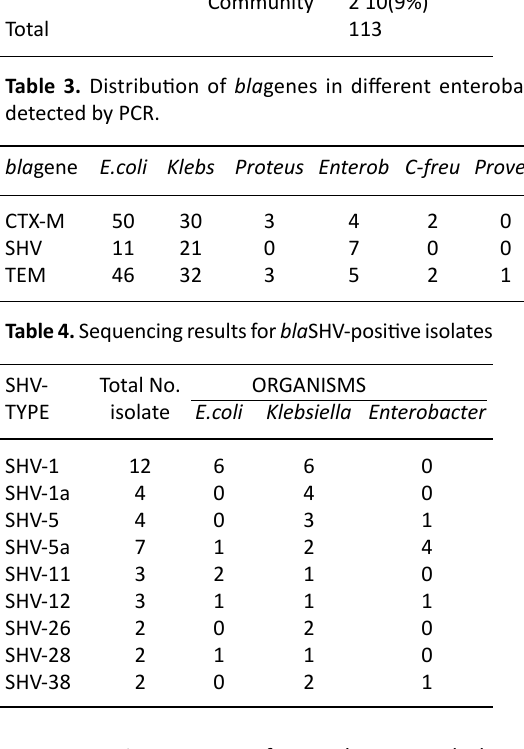
Table 2. Number of bacterial isolates included in the study Bacterial isolates Clinical